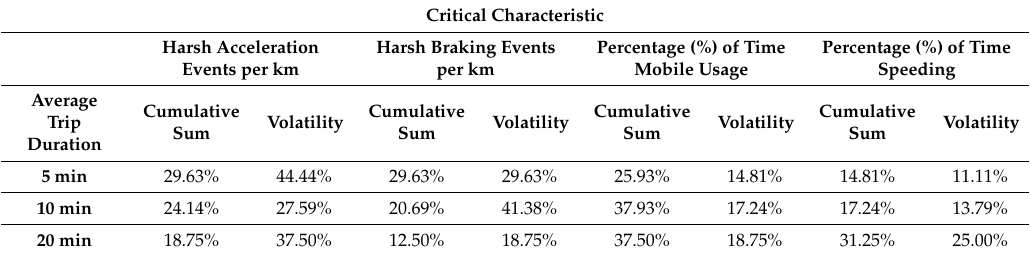
Table 3. Cumulative table of percentages of drivers and their critical characteristic for each duration.